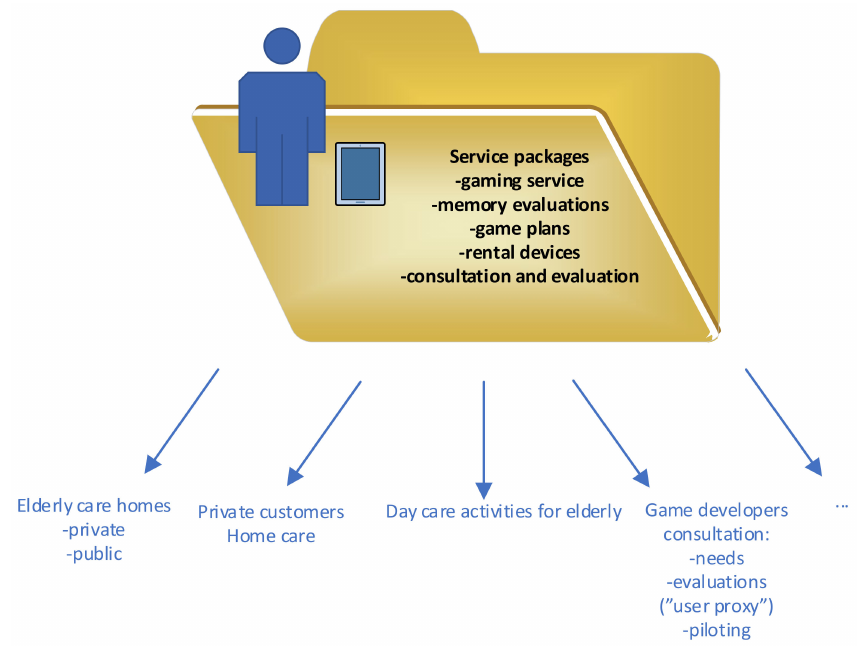
Figure 7. Service Model 2, based on the Chinese